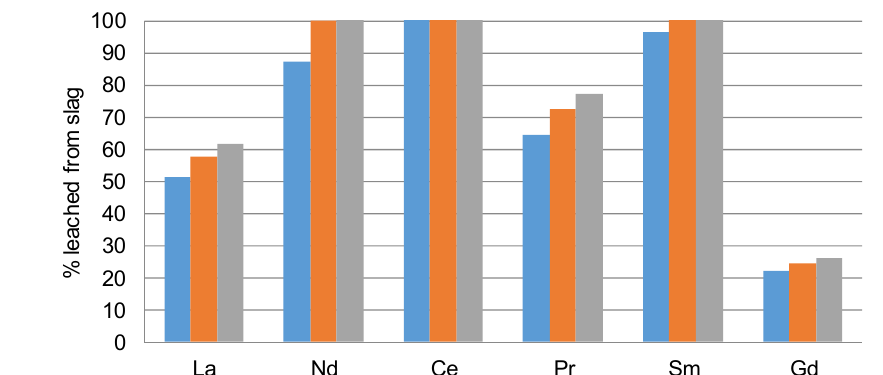
Figure 4 – Percentage of rare earth elements dissolved from slag in sulfuric acid after 1 hour (blue color), 2 hours (orange color) and 3 hours (gray color) using 1mol/L sulfuric